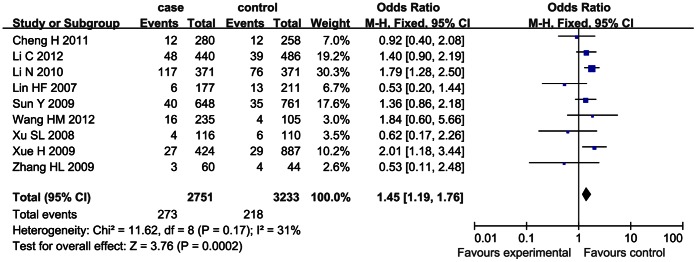
Forrest plot on the association between SNP 83 and ischemic stroke under the recessive model (CC/CT+TT).